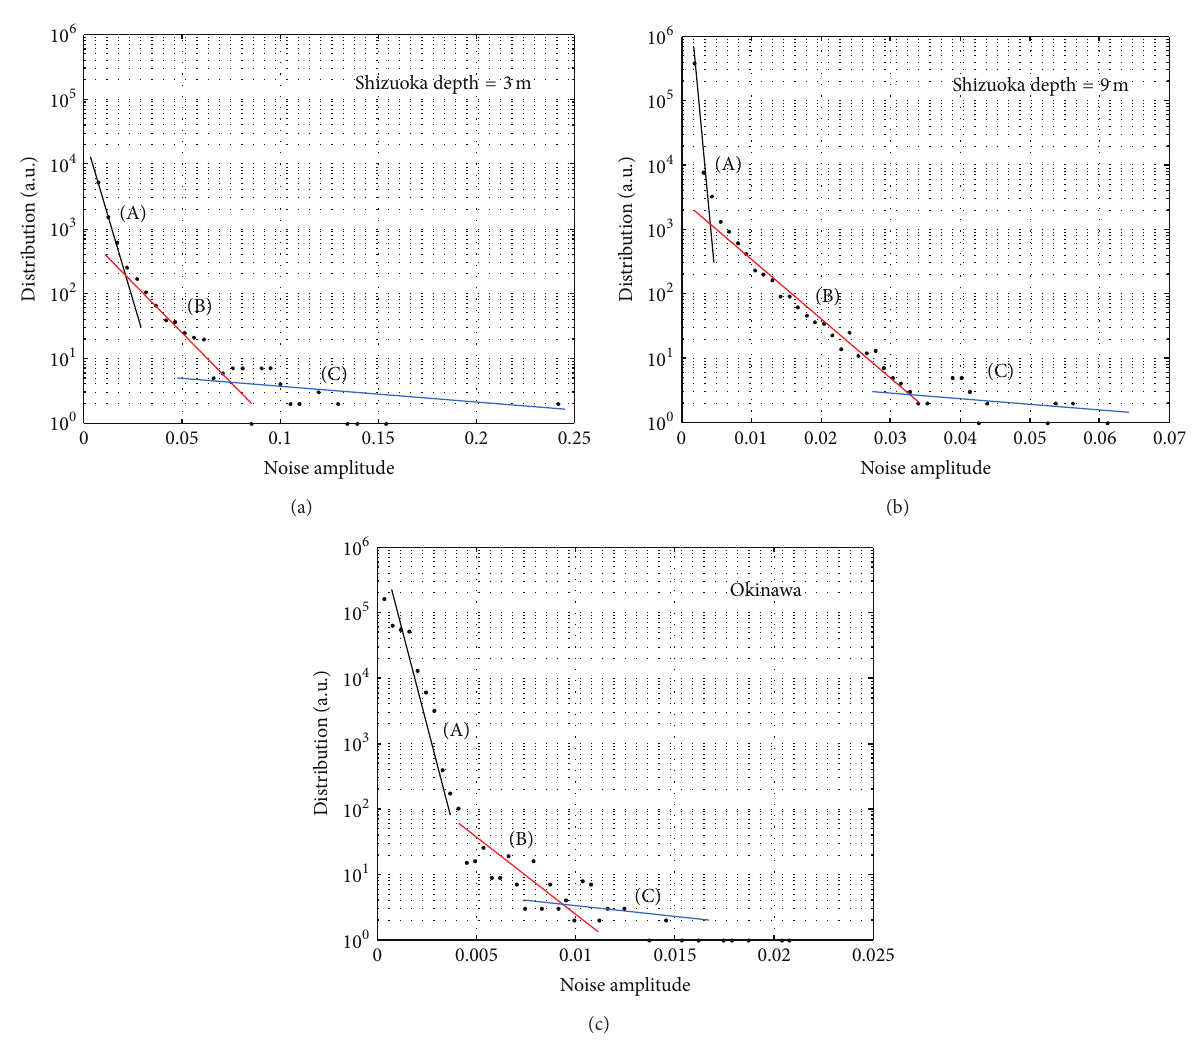
Figure 4: (a) Background noise distribution at Shizuoka (depth = 3m). (b) Background noise distribution at Shizuoka (depth = 9 m). (c) Background noise distribution at Okinawa.